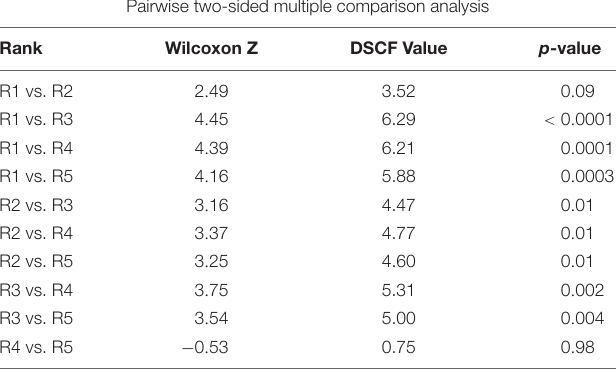
TABLE 3 | Dwass, Steel, Critchlow-Fligner multiple comparison for model scores between biogenic habitat ranks (two-sided comparison) for corrected data. Pairwise two-sided multiple comparison analysis